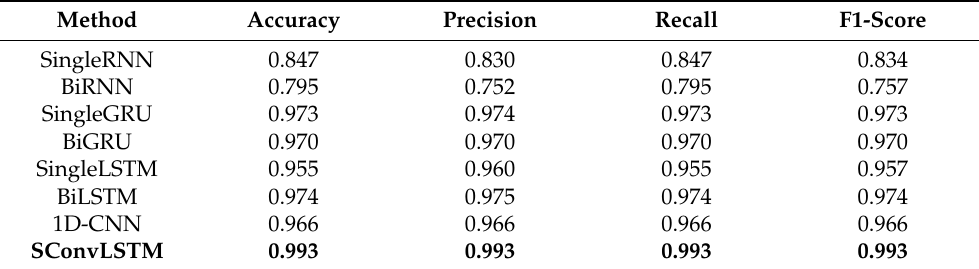
Table 5. Classification performance of proposed method and some based on deep learning methods on WISDM